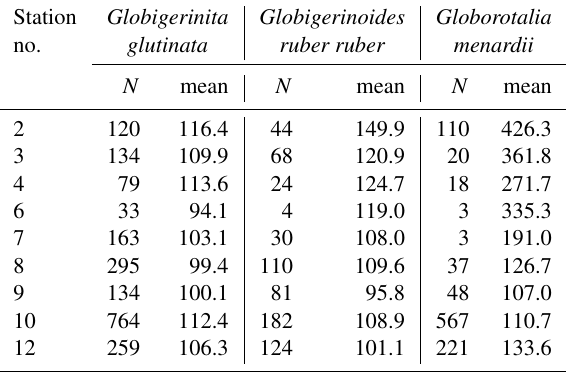
Table A3. Number of living specimens ( N ) and mean size (minor axis, in µm) of planktonic foraminifera per species and